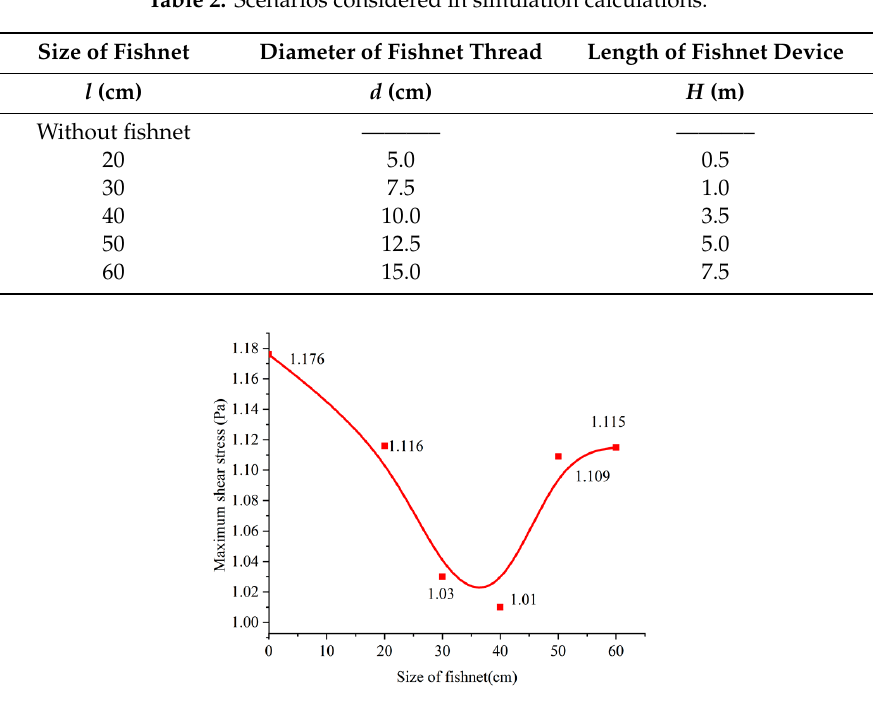
Figure 12. Influence of the fishnet size on the maximum shear stress on the surface of the seabed.